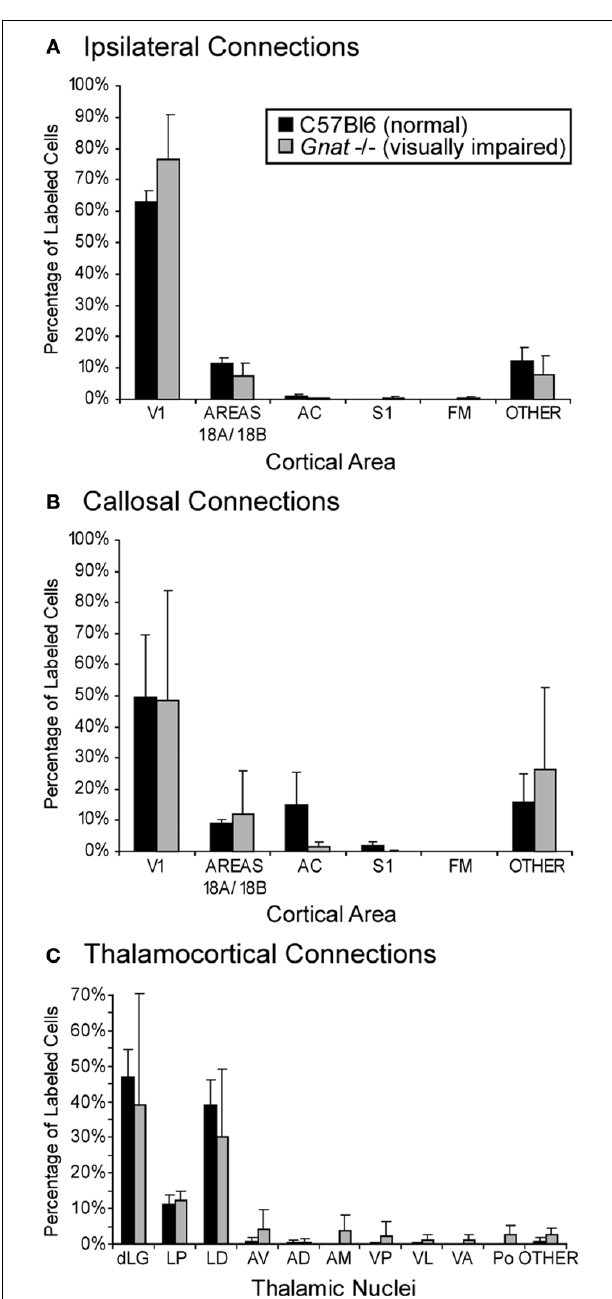
FIGURE 5 | Quantifi cation of Retrogradely Labeled Cell Bodies. Bar graphs indicate the percentage of labeled cells (mean ± SD) in ipsilateral cortex (A) , contralateral cortex (B) , and thalamus (C) resulting from neuroanatomical tracer injections in V1. Ipsilateral cortical connections of V1 in C57Bl6 and Gnat − / − mice were predominantly intrinsic connections within V1 and connections with areas 18a and 18b. Callosal connections of V1 in C57Bl6 and Gnat − / − mice also showed a large percentage of labeled cells within V1 and areas 18a and 18b. In addition, C57Bl6 mice also showed an intermediate amount of label within auditory cortex. The majority of labeled cells found in the thalamus for C57Bl6 and Gnat − / − mice are found in the thalamic nuclei associated with visual processing (dLG, LP, and LD). In addition to these normal connections, Gnat − / − mice also show inappropriate connections with a number of thalamic nuclei. See Table 1 for list of